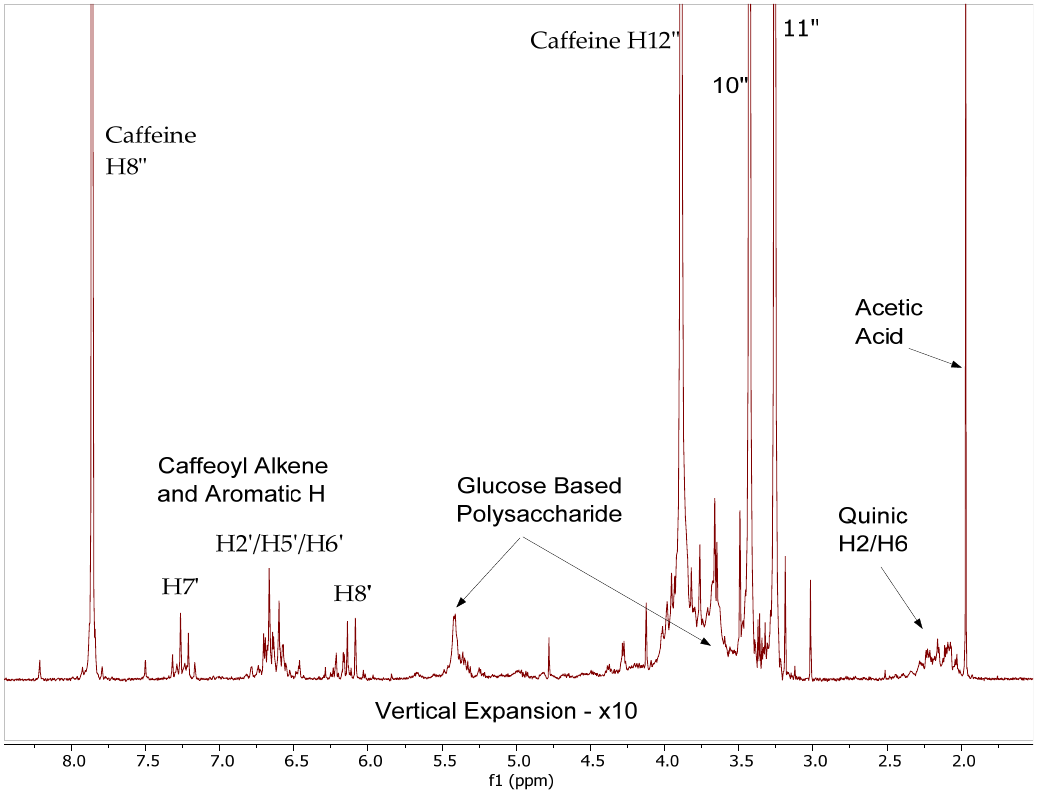
Figure 9. Caffeoyl region of the 1 H NMR spectra of CEWCCE in D 2 O showing relative shifts in caffeine (H8”, 12”,10”,11”) and caffeoyl (H7 ′ ,2 ′ ,5 ′ ,6 ′ ,8 ′ ) resonances. Caffeine resonances are off scale to observe CQA signals.